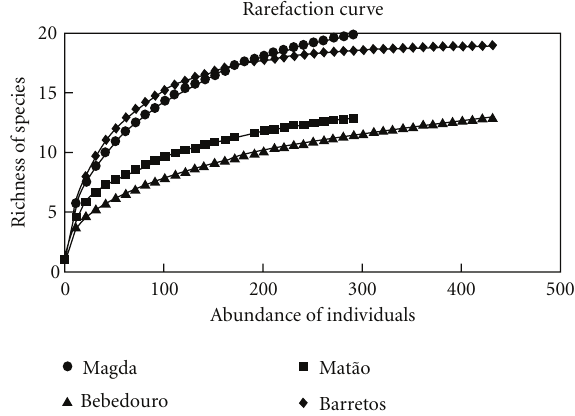
Figure 1: Rarefaction curve for the socialwaspscollected in the four studied areas.